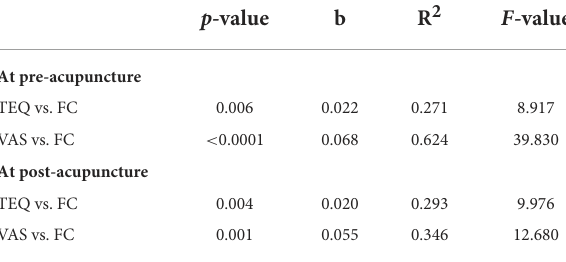
TABLE 4 Linear regressions between clinical symptoms of tinnitus and FC.